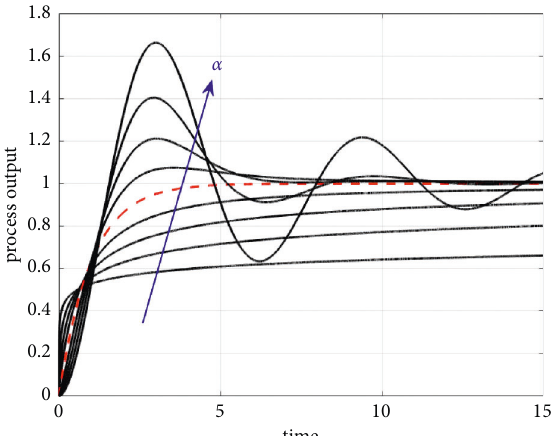
Figure 1: Step responses of the considered fractional-order system with α ∈ [0.2, 1.8]. The step response for α � 1 is in the red dashed